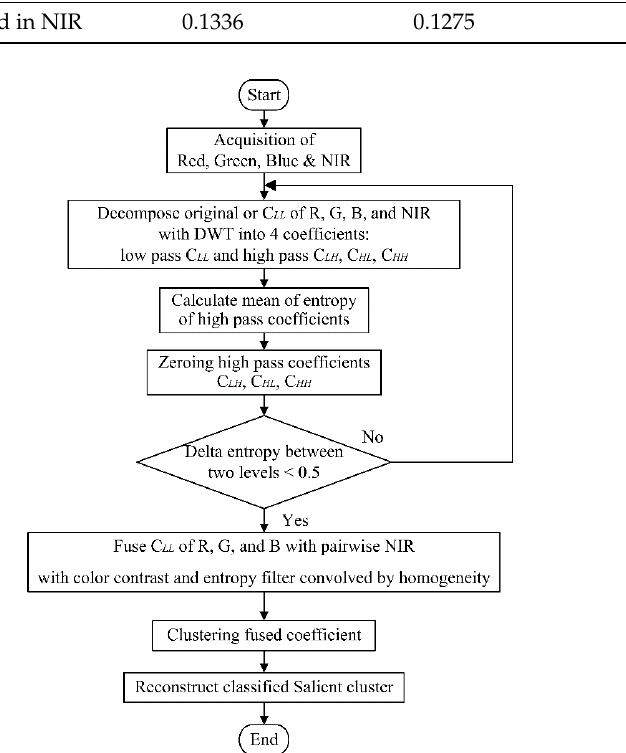
Table 2. STD of intensity of NIR component pairwise for types of color images.